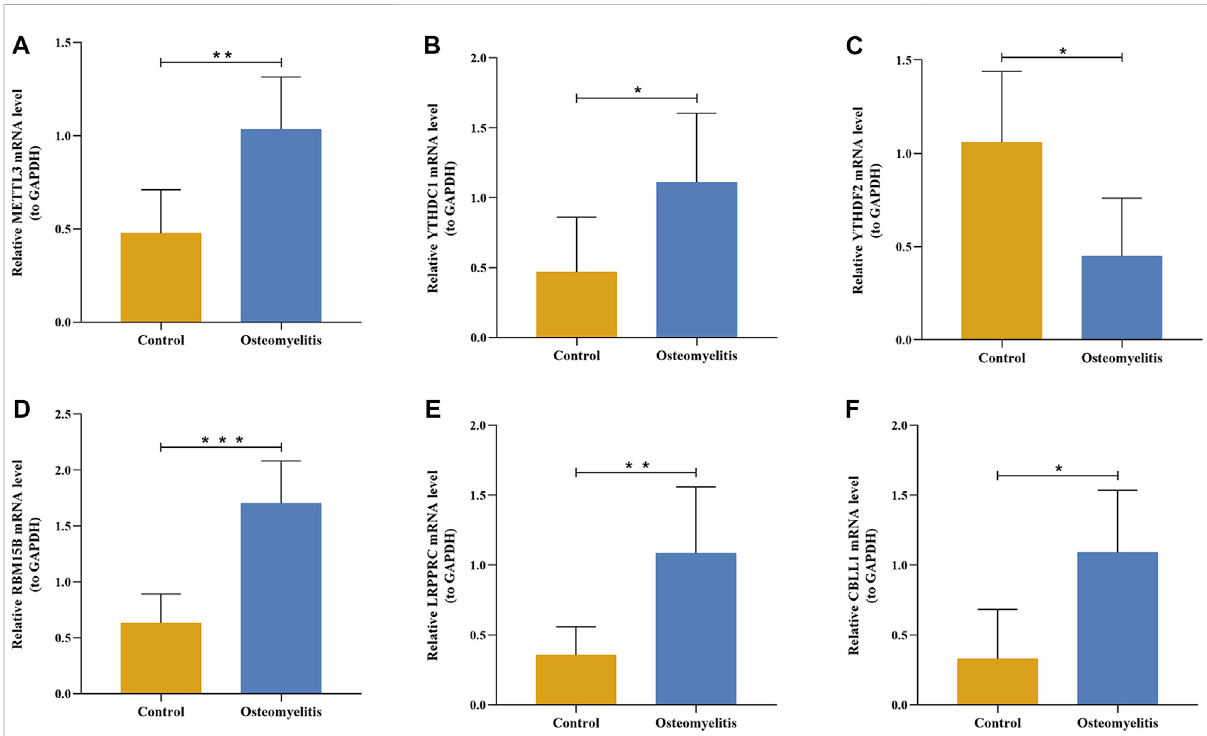
FIGURE 10 The mRNA expression levels of 6 signi fi cant m6A regulators in the focal bone tissue and healthy bone tissue of rat model of osteomyelitis. The mRNA expression levels of METTL3 (A) , YTHDC1 (B) , YTHDF2 (C) , RBM15B (D) , LRPPRC (E) , and CBLL1 (F) in focal bone tissues were signi fi cantly higher than that of healthy bone